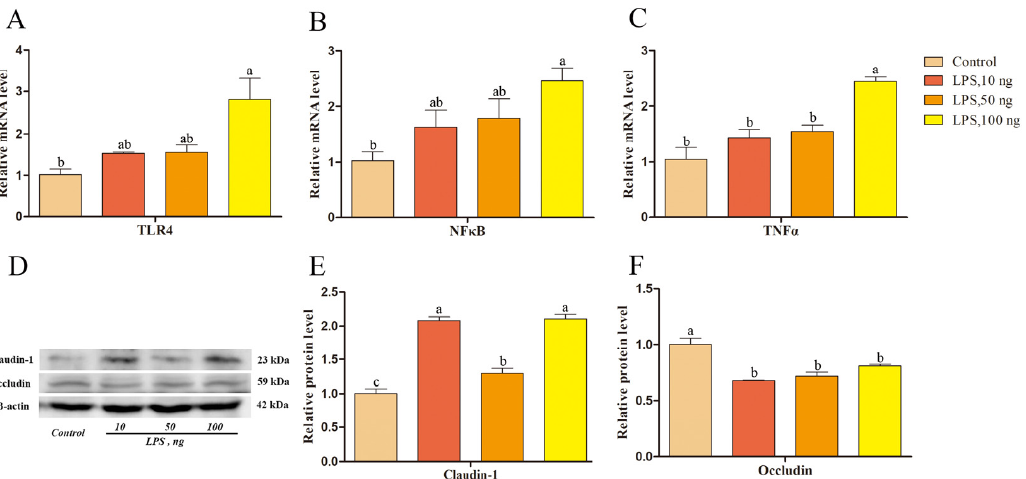
Figure 6. Authentication of LPS-induced inflammatory response in endometrial epithelial cells and the effect of LPS on claudin-1 and occludin protein expression in epithelial cells. ( A ) Relative TLR4 mRNA expression level. ( B ) Relative NF κ B mRNA expression level. ( C ) Relative TNF α mRNA expression level. ( D ) Western blot of claudin-1 and occludin. ( E ) Relative claudin-1 protein expression level. ( F ) Relative occludin protein expression level. Different lowercase letters indicate a significant difference at p < 0.05. LPS, lipopolysaccharide. Concentration is measured in ng/mL.